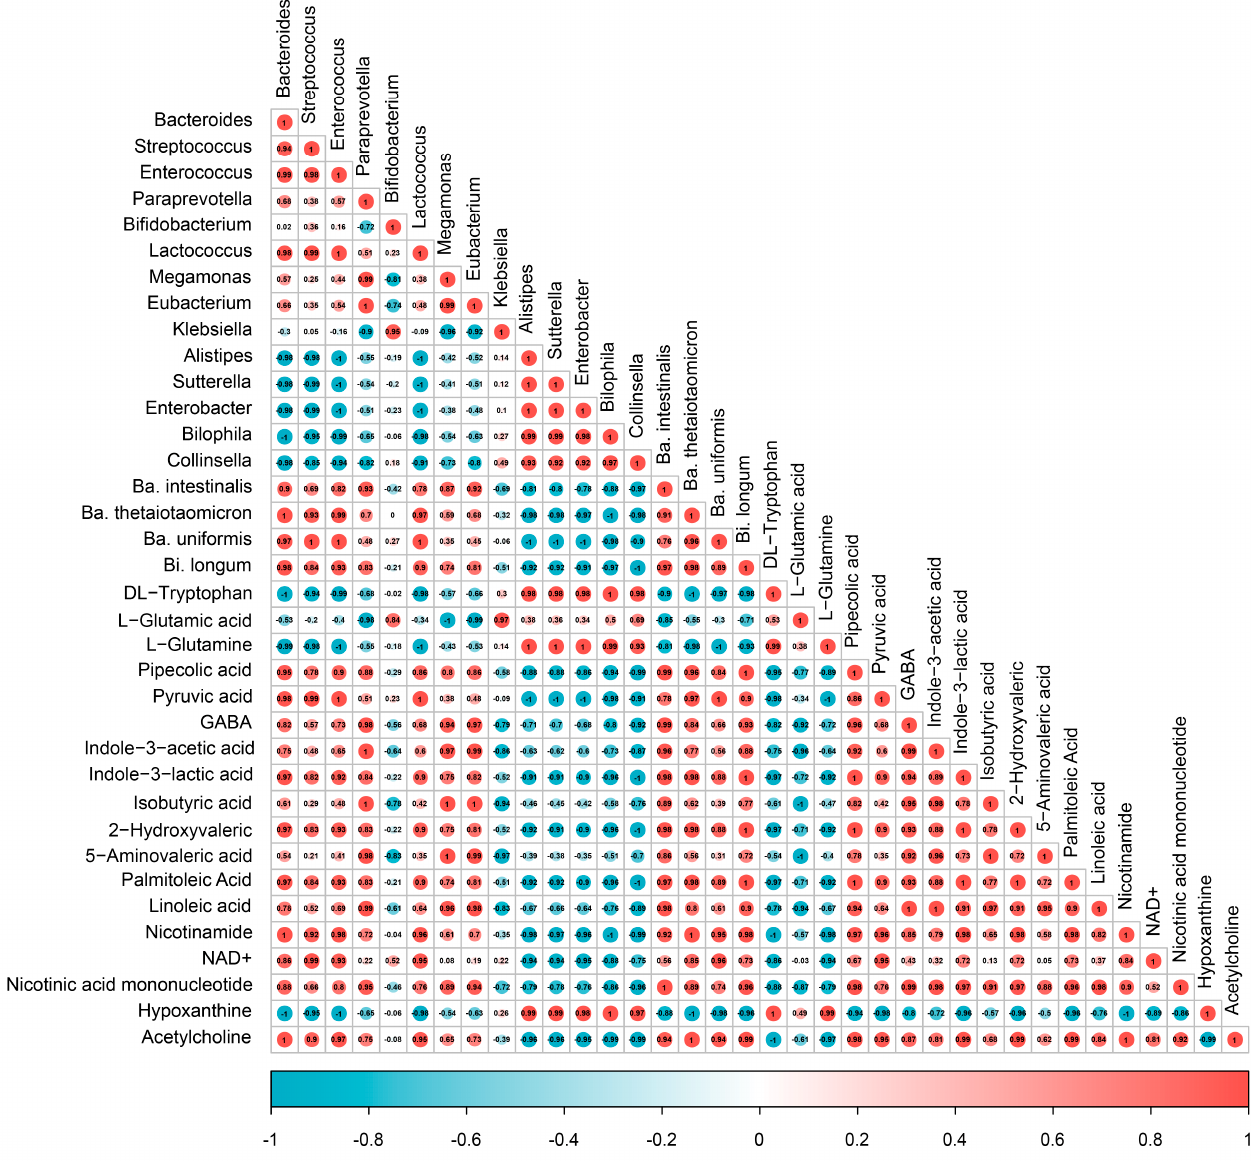
Figure 6. The Spearman correlation analysis between specific gut microbiota and metabolites.